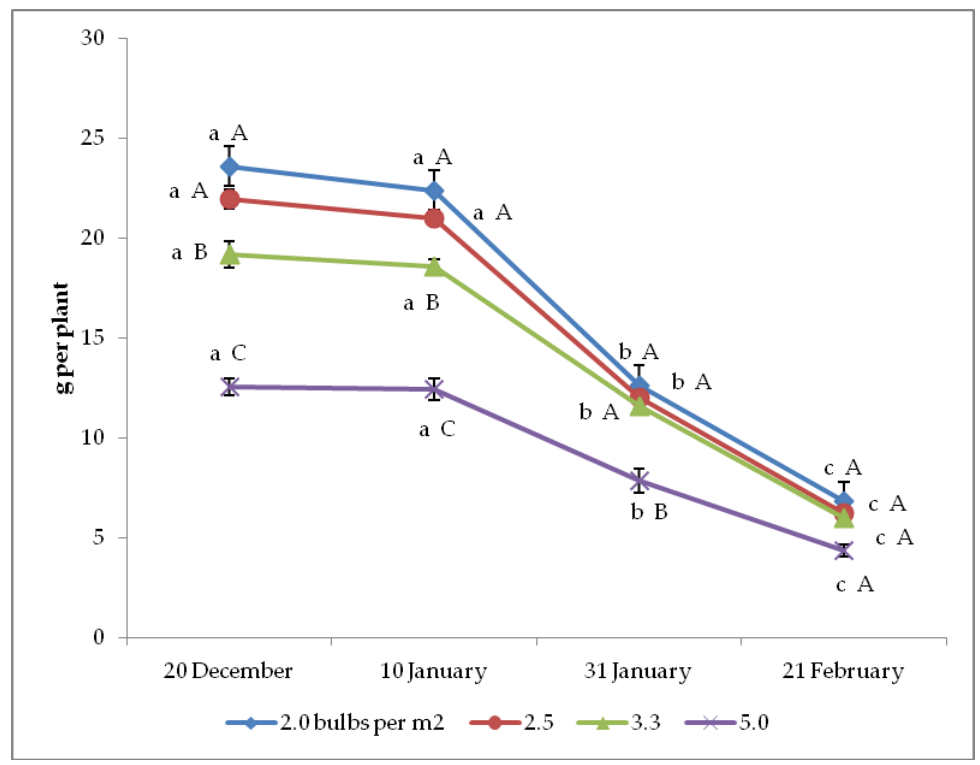
Figure 1. Interaction between bulb planting time and density on onion seed yield per plant ( n = 3). Different letters mean significant difference in the comparison between planting times (lowercase letters) or between bulb densities (capital letters), according to the Duncan test at p ≤ 0.05. Standard deviation bars are shown per each value.